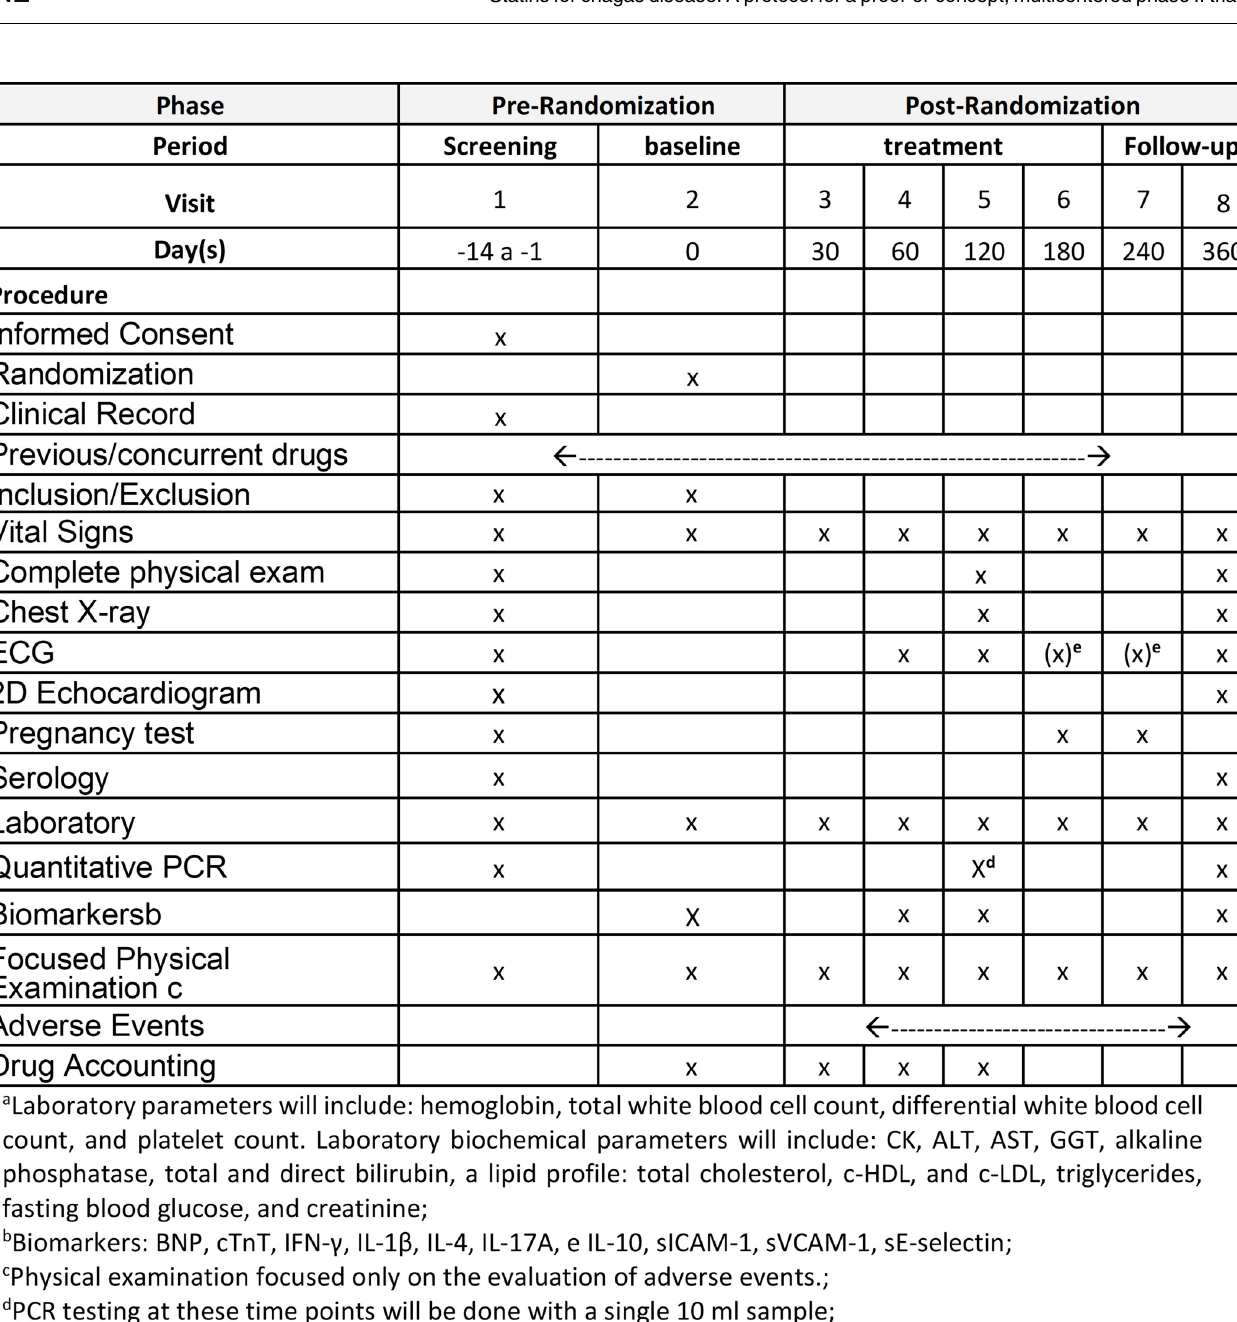
Fig 1. Schedule of events and procedures for each subject during the recruitment phase under the SPIRIT